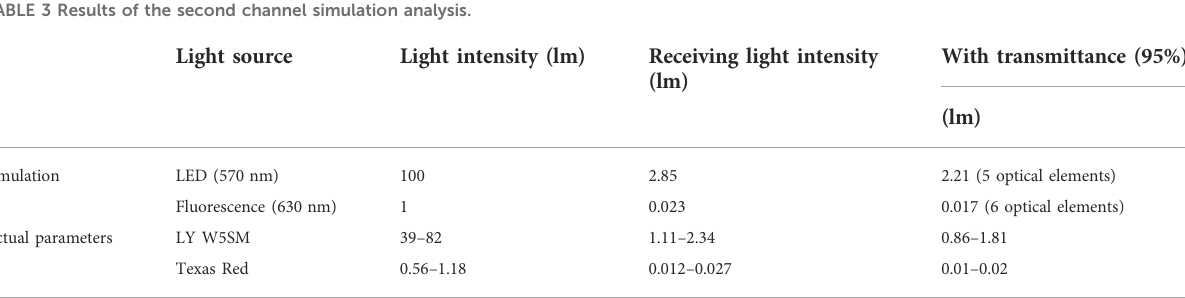
TABLE 3 Results of the second channel simulation